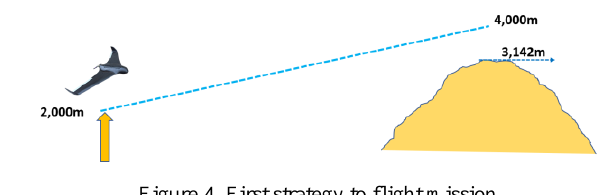
Figure 4. First strategy to flight mission